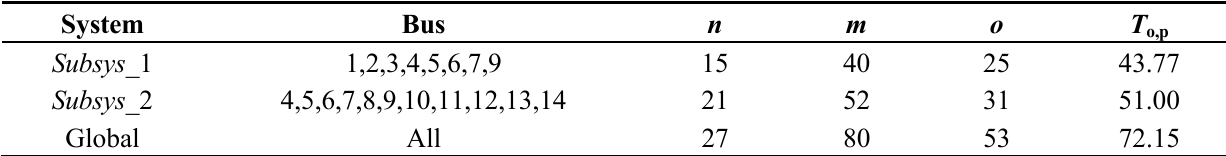
Table 4. Decomposition of IEEE 14-bus system.